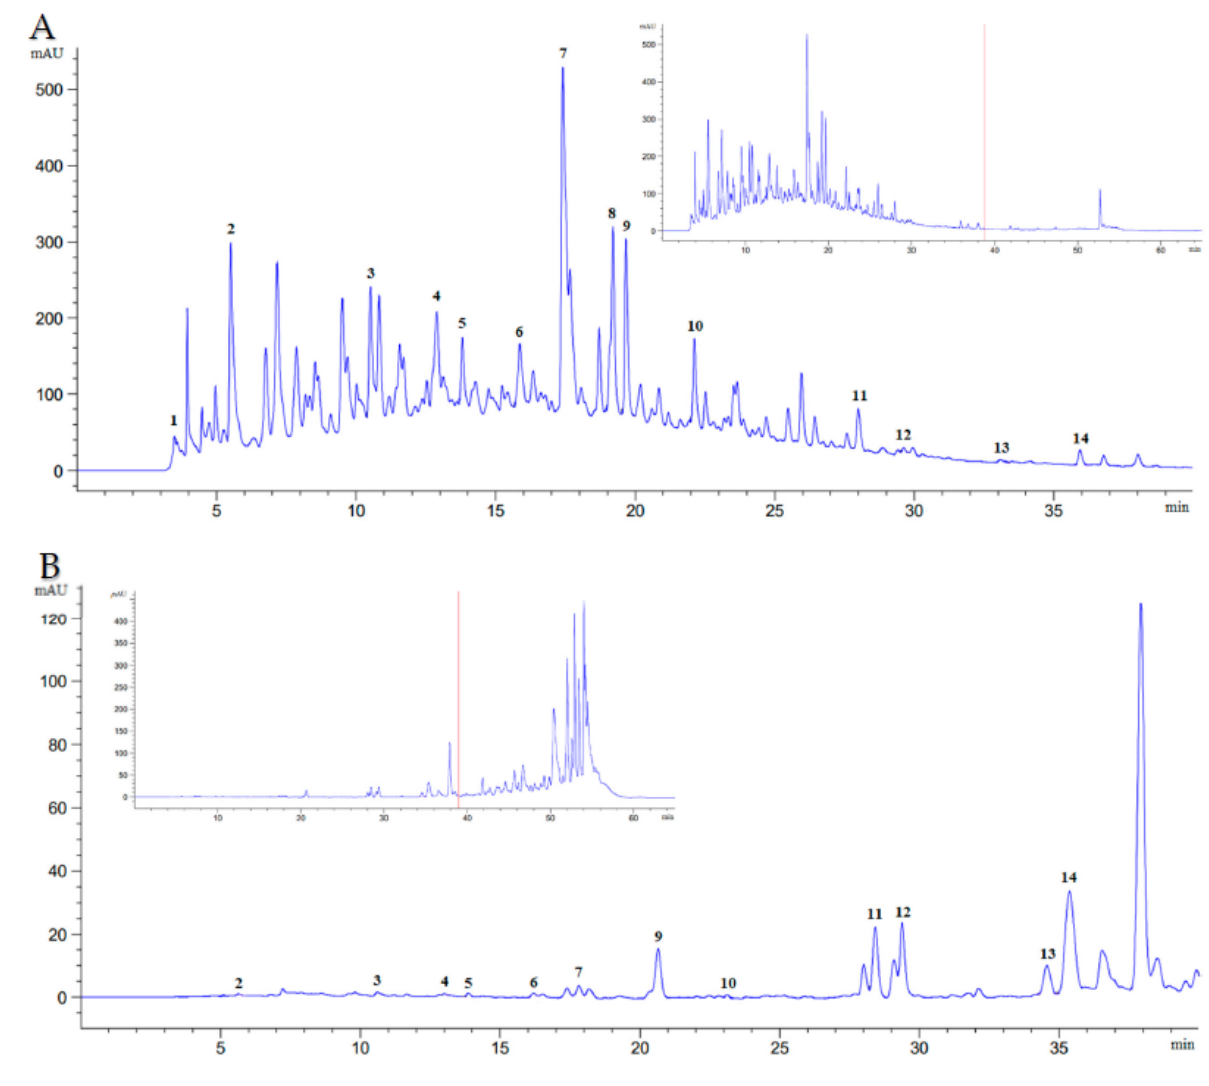
Figure 1. Chromatogram of Farang ( P. guajava L.) leaves at λ = 272 nm, flow rate 0.9 mL/min, for